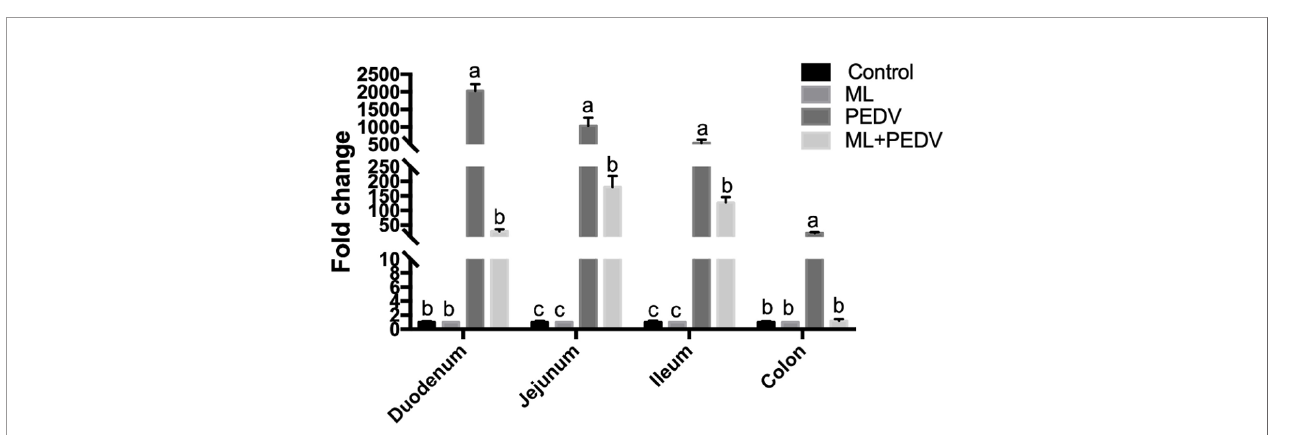
FIGURE 3 | Effects of ML administration on relative viral load levels in piglets infected with PEDV. Bars not sharing a common lowercase letter differ signi fi cantly (p < 0.05).